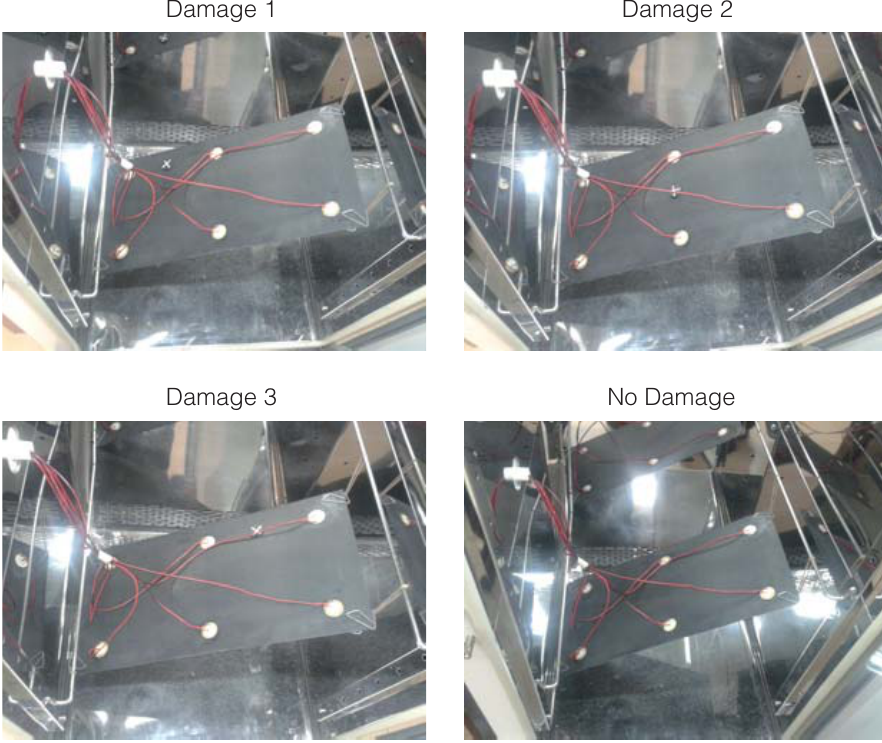
Figure 19. Composite plate in the climatic